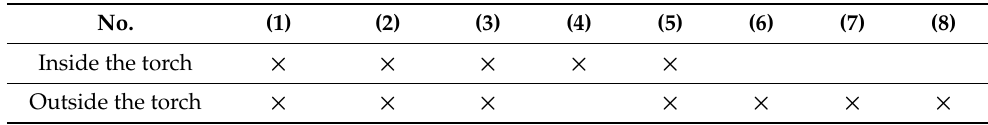
Table 1. Assumptions used in the two simulation